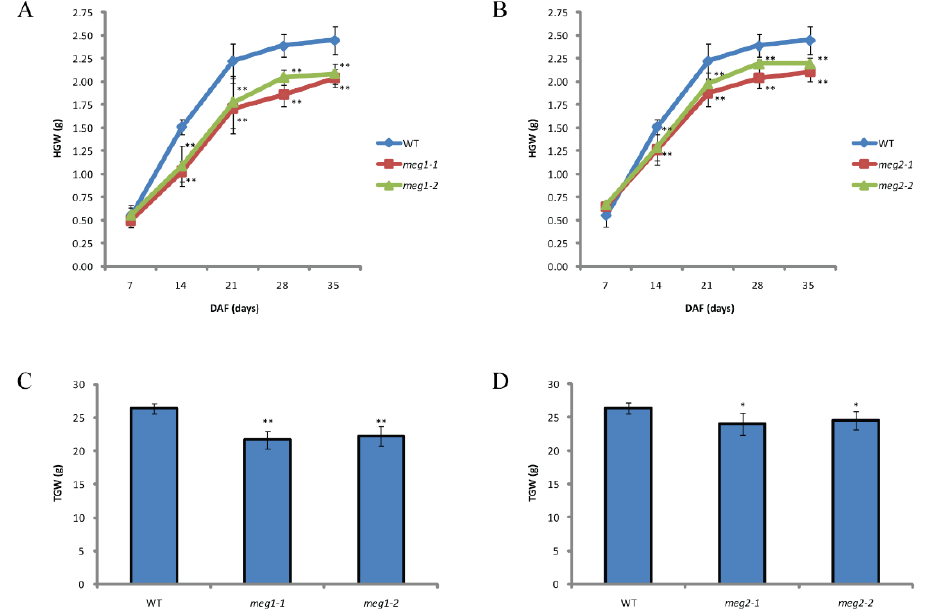
Figure 5. Comparison of grain filling between WT (wild type) and mutants. ( A ) Comparison of dynamic measurement of grain filling between wild type and two mutants of MEG1 . ( B ) Comparison of dynamic measurement of grain filling between wild type and two mutants of MEG2 . ( C ) Comparison of thousand-grain weight (TGW) between wild type and two mutants of MEG1 . ( D ) Comparison of TGW between wild type and two mutants of MEG2 . HGW, hundred-grain weight. Student’s t test was used for statistical analysis (*, 0.01 < p < 0.05 and **, p < 0.01).